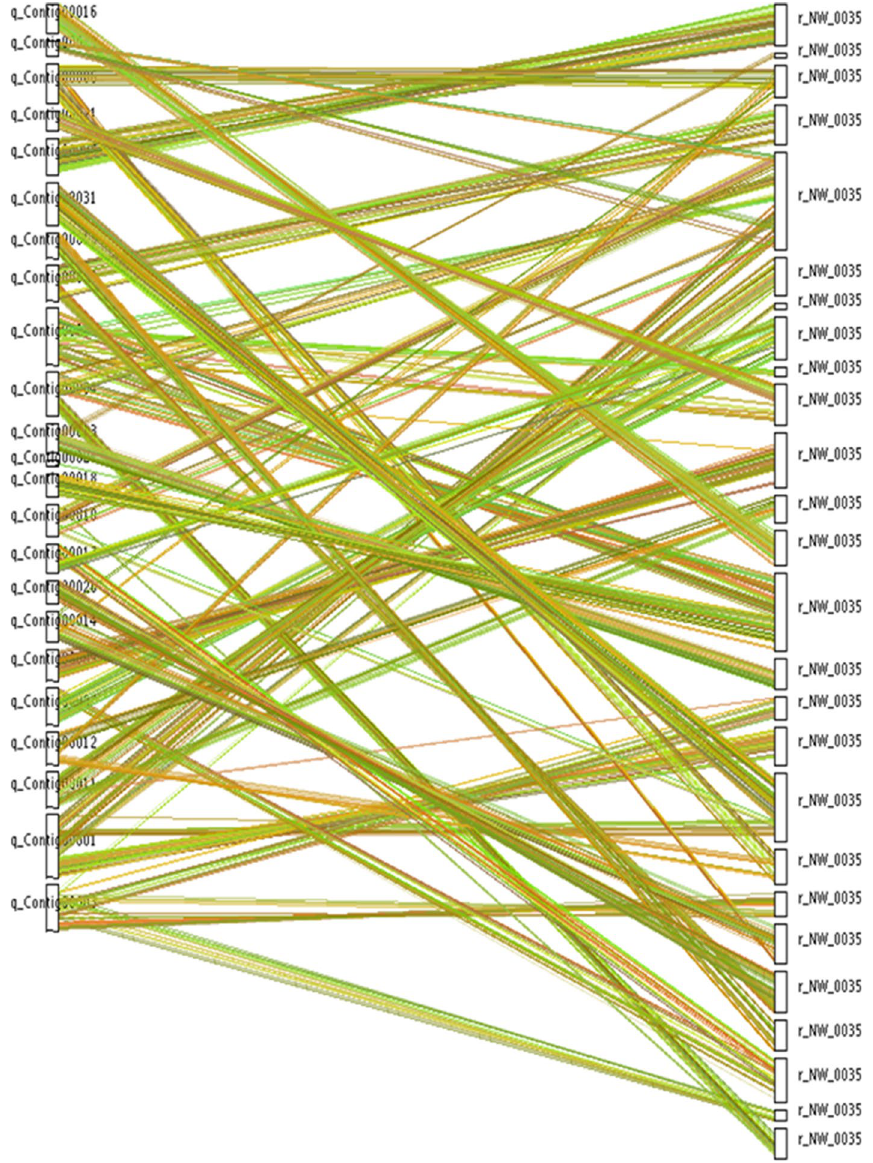
Figure 4. Comparative genome collinearity analysis of Sc. and Lm. The assembled genome is shown on the left and the reference genome on the right. Analogous genes between species are joined with a line. Thus, the homology of coding sequence and structure between modular genomes is established, whereby mapping information of known genomes is used to locate genes within other genomes that, in turn, reveals potential functions of genes, evolutionary relationships between species and internal structures of genomes. MCScanX (https ://chibb a.pgml.uga.edu/mcsca n2/MCSca nX.zip) was used for drawing program.